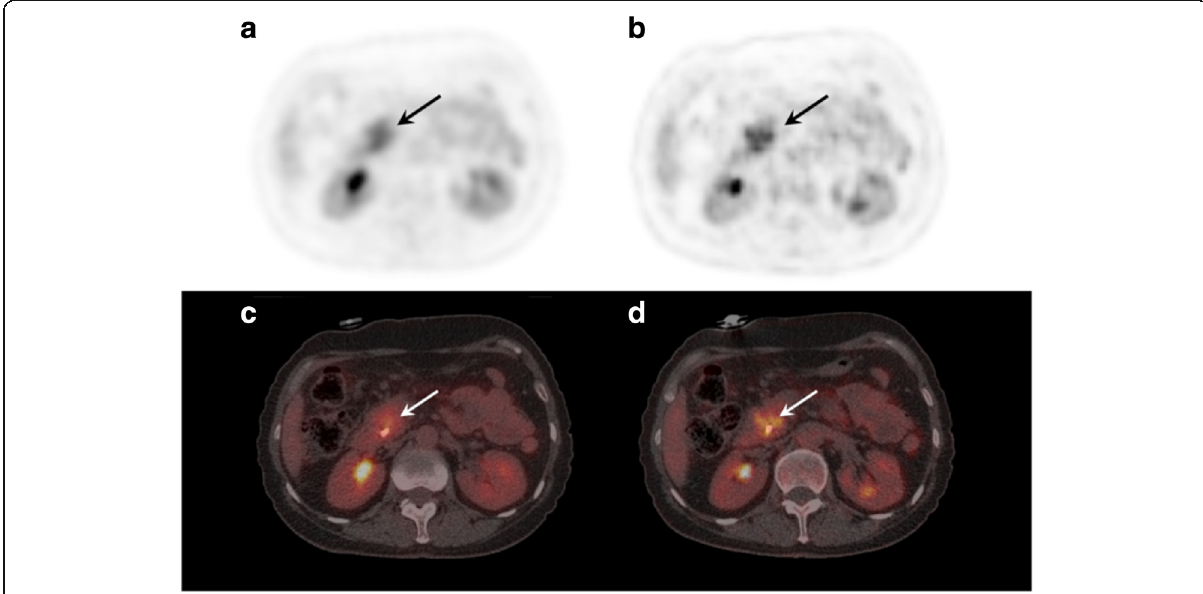
Fig. 2 Optimal respiratory gating impacts assessment of intra-tumoral heterogeneity. A [ 18 F]FDG PET/CT scan reconstructed according to EANM guidelines ( a , c ) and with optimal respiratory gating ( b , d ) showing changes in the heterogeneous pattern of intra-tumor [18F]FDG